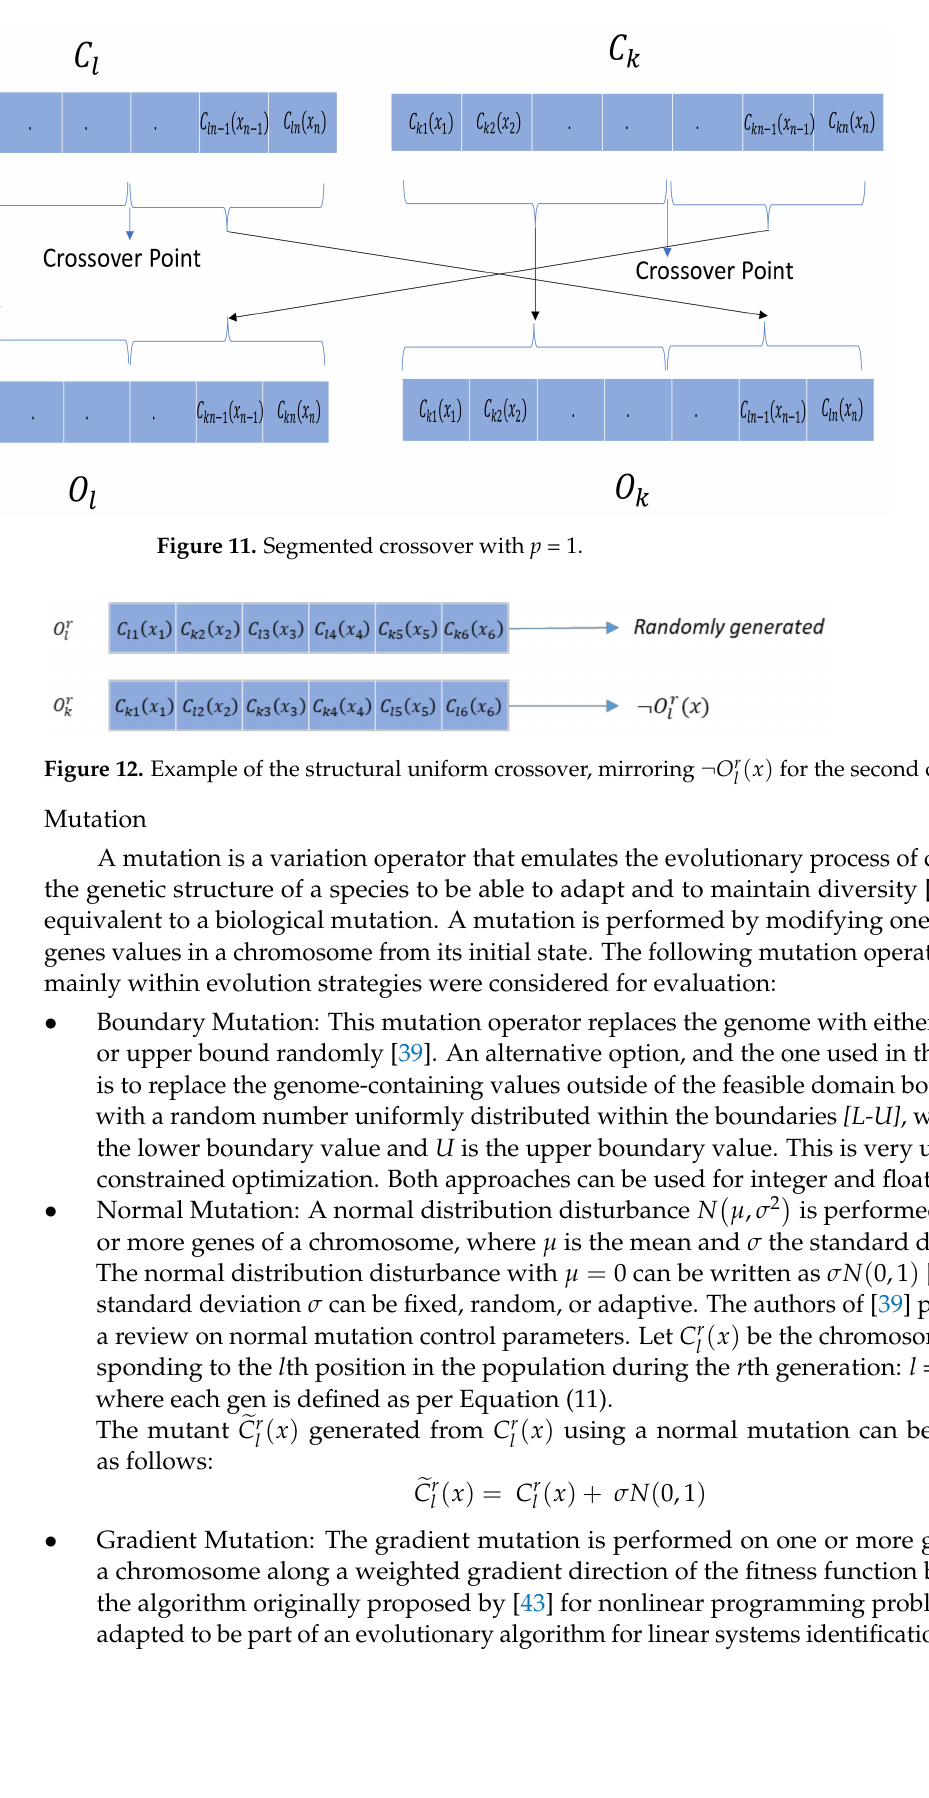
Figure 11. Segmented crossover with p = 1.